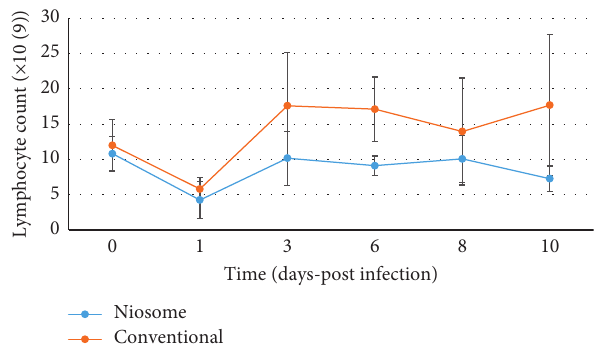
Figure 6: Graph showing lymphocyte counts in Sprague Dawley rats after infection with Pseudomonas aeruginosa and treatment with niosome and conventional levofloxacin ( p < 0 . 03).